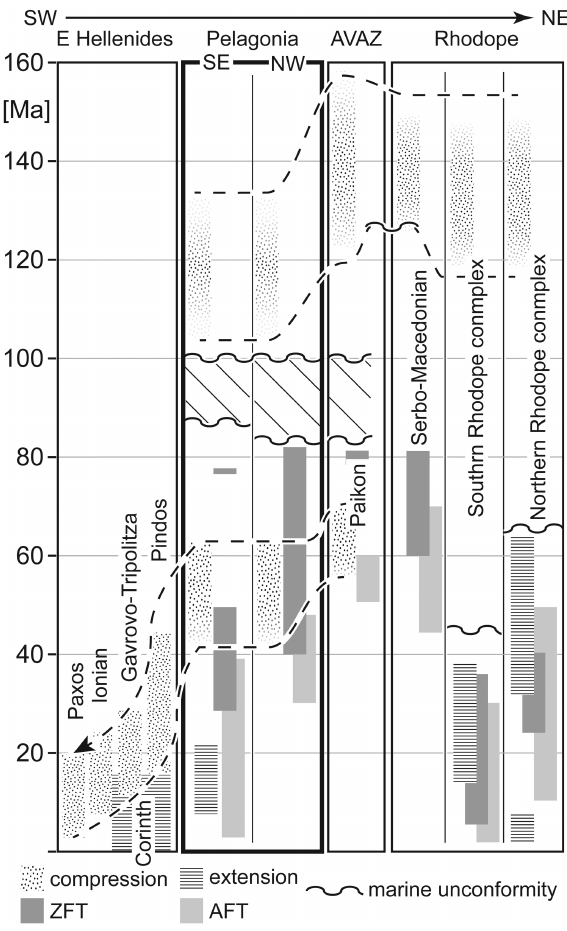
Figure 2. Correlation of zircon and apatite FT ages (references in Fig. 1) with main tectonic events. From southwest to northeast: tec- tonism of Paxos, Ionian, Gavrovo-Tripolitza and Pindos zones (typ- ical localities of the first deposition of the synorogenic mass flow deposits) according to Papanikolaou (1997); Pelagonian unconfor- mity and deformation according to Kilias et al. (2010) and Schenker et al. (2014), respectively; Paikon (Late Cretaceous/Early Tertiary window in the AVAZ) tectonism according to Bonneau et al. (1994) and Mercier and Vergely (1994); deformation and transgressions of Serbo-Macedonia (the westernmost continental fragment of the Rhodope) and the Southern and Northern Rhodope Complexes (two extensional metamorphic core complexes) according to Burg (2012) and Ivanova et al.